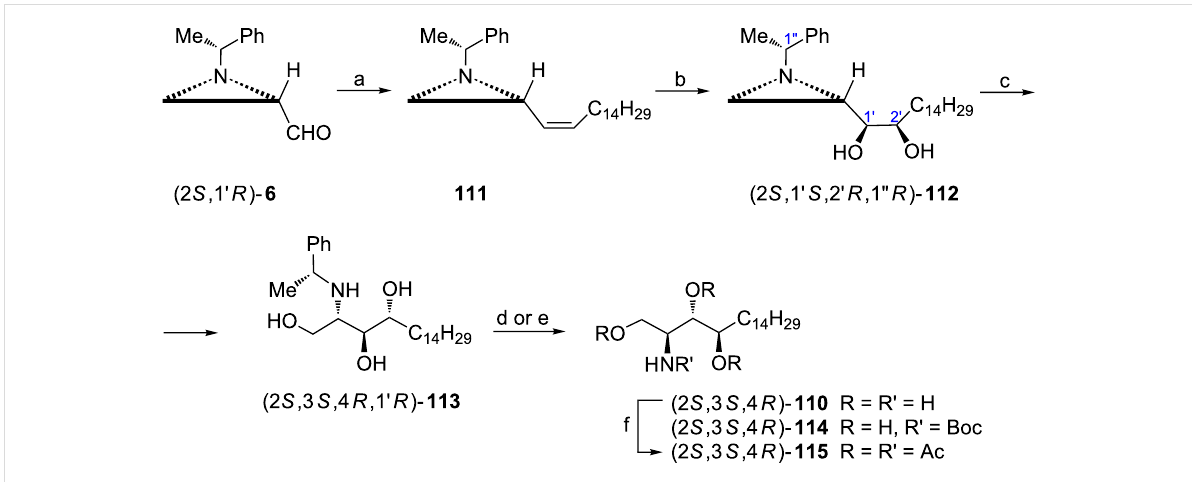
Scheme 29: Synthesis of (2 S ,3 S ,4 R )-2-aminooctadecane-1,3,4-triol ( ᴅ - ribo -phytosphingosine) (2 S ,3 S ,4 R )- 110 . Reagents and conditions: a) Ph